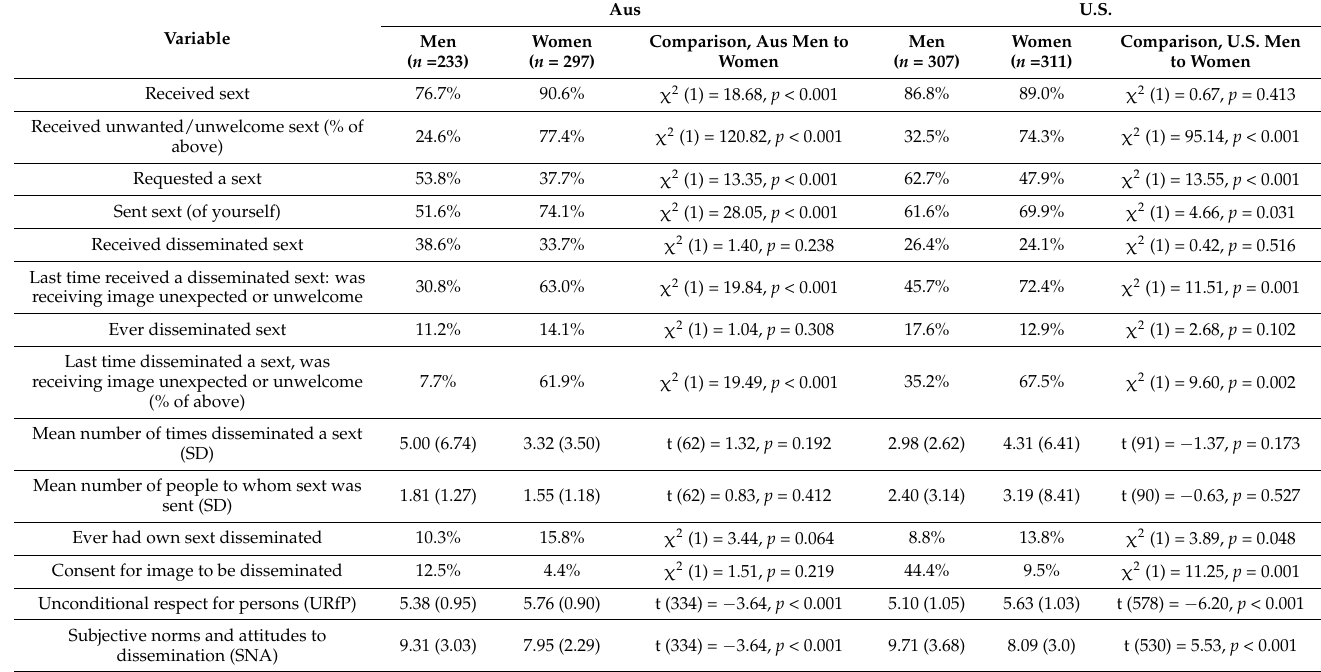
Table 2. Sexting behaviours by gender within